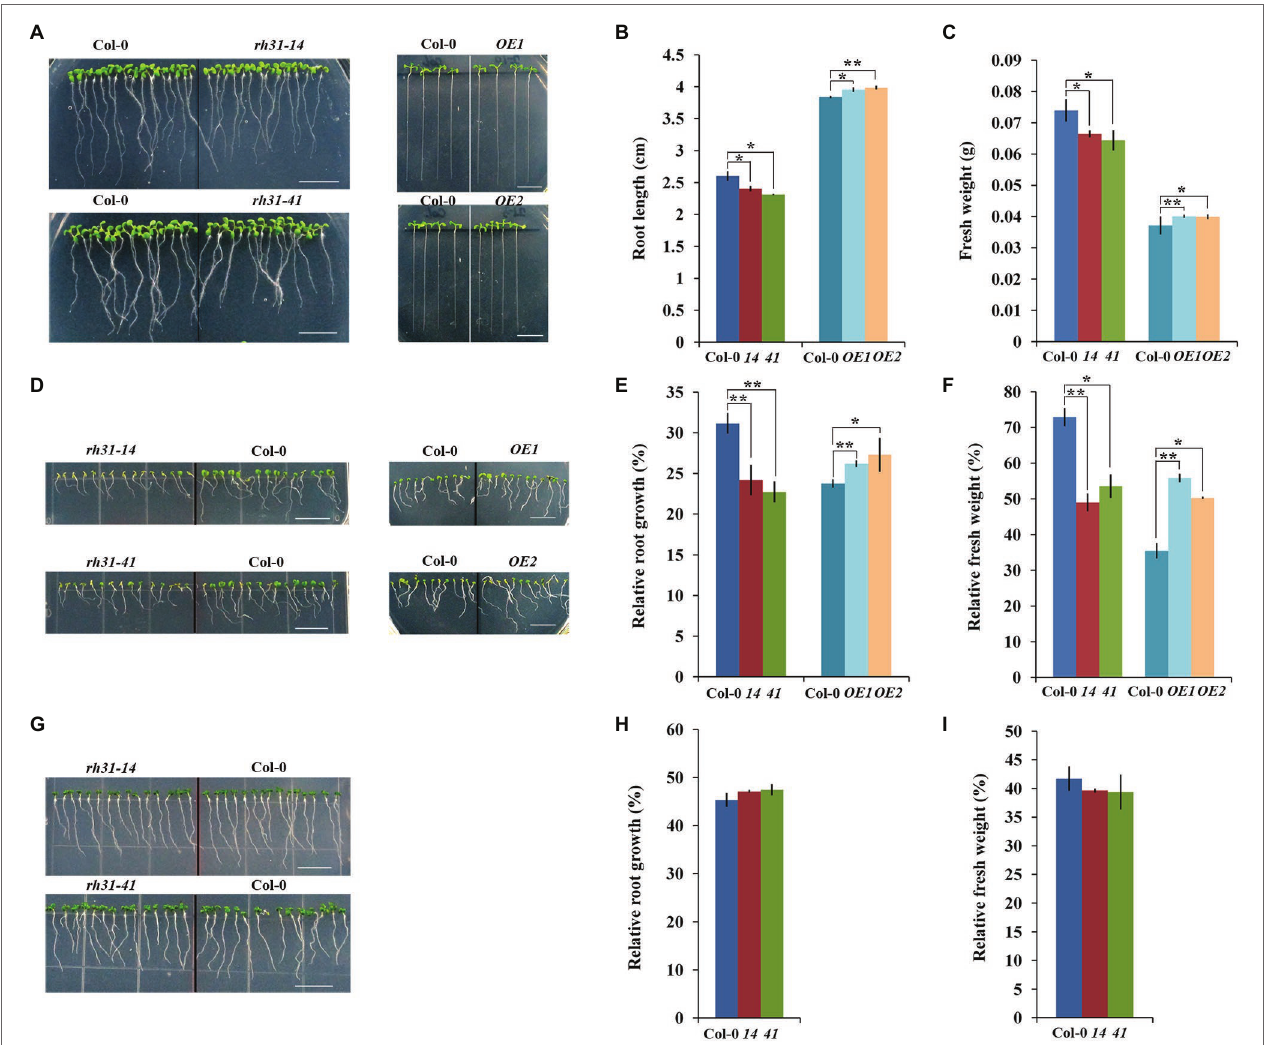
FIGURE 5 | Growth phenotype characterization of rh31 and RH31 overexpression ( OE 1, OE 2) lines under normal and stress conditions. (A) Phenotype of 7-day- old rh31 and 11-day-old OE seedlings under normal condition. After germinated for 24 h under normal condition, synchronized growth of Col-0, rh31 , and OE seedlings were transferred to MS medium for another 6 days ( rh31 ) or 10 days ( OE ). Experiments were repeated three times with similar results. Scale bars = 1 cm. (B) Root length of seedlings shown in (A) . The primary roots of at least 30 seedlings were measured and reported as the mean length ( n = 3 replicates). (C) Fresh weight of 11-day-old rh31 and OE seedlings under normal condition. 40 ( rh31 ) and 20 ( OE ) seedlings were measured per replicate ( n = 3 replicates). (D) Phenotype of rh31 and OE seedlings treated with 150 mM NaCl for 10 days. After germinated for 24 h under normal condition, synchronized growth of Col-0, rh31 , and OE seedlings were transferred to MS medium with or without 150 mM NaCl for another 10 days. Experiments were repeated three times with similar results. Scale bars = 1 cm. (E) Relative root growth of seedlings shown in (D) . The primary roots of at least 30 11-day-old seedlings were measured and relative growth was reported as the mean length ( n = 3 replicates). (F) Relative fresh weight of seedlings shown in (D) . 40 ( rh31 ) and 20 ( OE ) seedlings were measured per replicate, and relative fresh weight was reported as the mean fresh weight ( n = 3 replicates). (G) Phenotype of rh31 seedlings treated with 250 mM mannitol for 10 days. After germinated for 24 h under normal condition, synchronized growth of Col-0 and rh31 seedlings were transferred to MS medium with or without 250 mM mannitol for another 10 days. Experiments were repeated three times with similar results. Scale bars = 1 cm. (H) Relative root growth of rh31 seedlings shown in (G) . The primary roots of at least 30 11-day-old seedlings were measured and relative growth was reported as the mean length ( n = 3 replicates). (I) Relative fresh weight of seedlings shown in (G) . 40 seedlings were measured per replicate, and relative fresh weight was reported as the mean fresh weight ( n = 3 replicates). * p < 0.05 and ** p < 0.01 (Student’s t -test) indicate significant differences between rh31 , OE , and Col-0 plants. Error bars indicate the standard error for the average of three independent